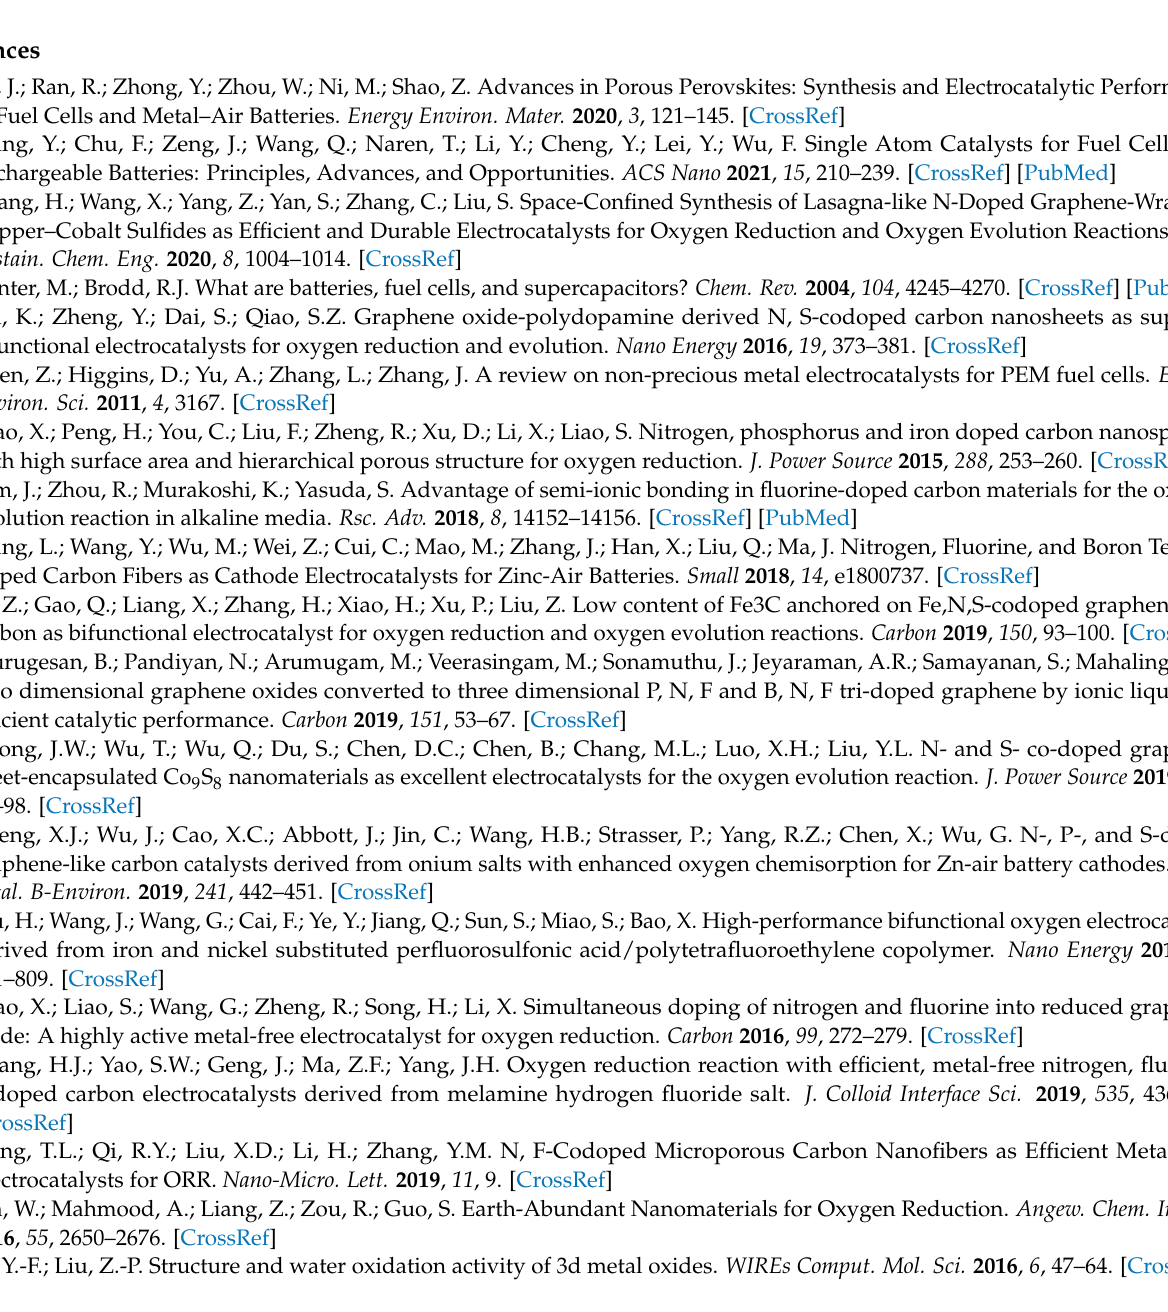
Table S3. Comparison of ORR and OER activity parameters with other recently reported highly active non-noble metal bifunctional electrocatalysts. Table S4. Comparison of the power density for Zn-air